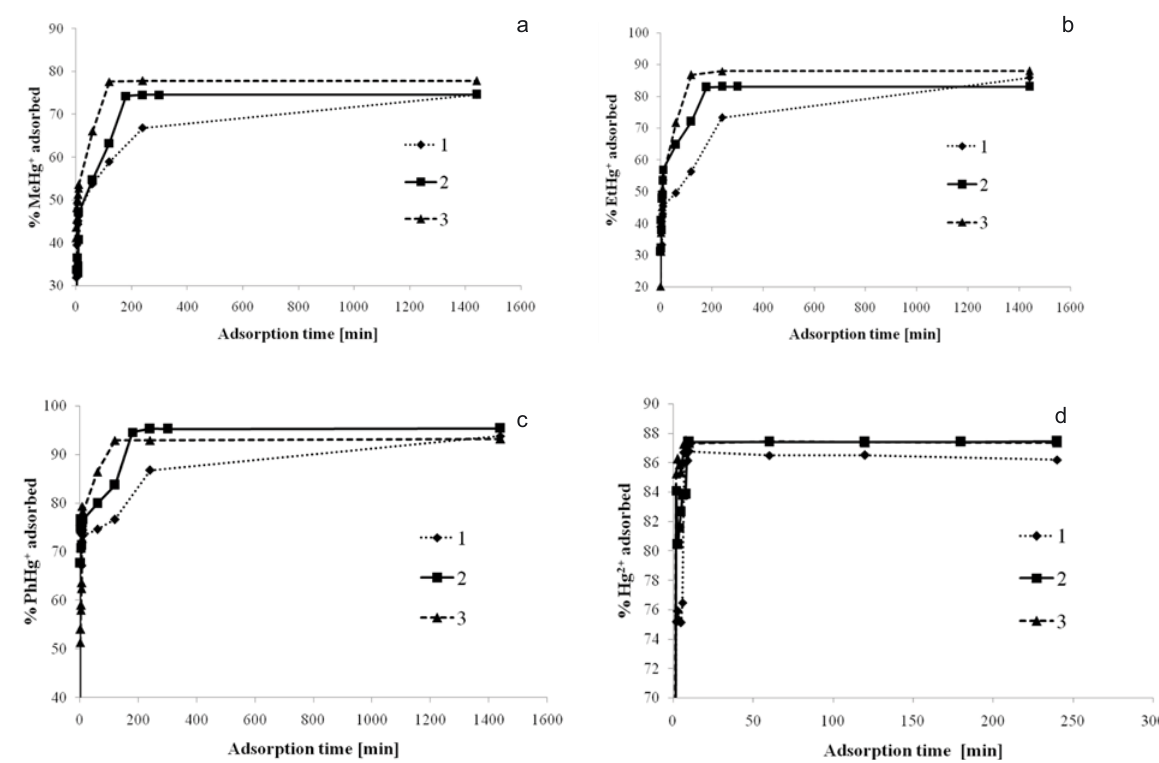
Figure 2. Effect of temperature for (1) static system, (2) agitated system, (3) stirred system (agitated system, 20 g of ZL 1606 sediment, 250 mL of water, pH 5.2, Hg concentration 0.2 mg L -1